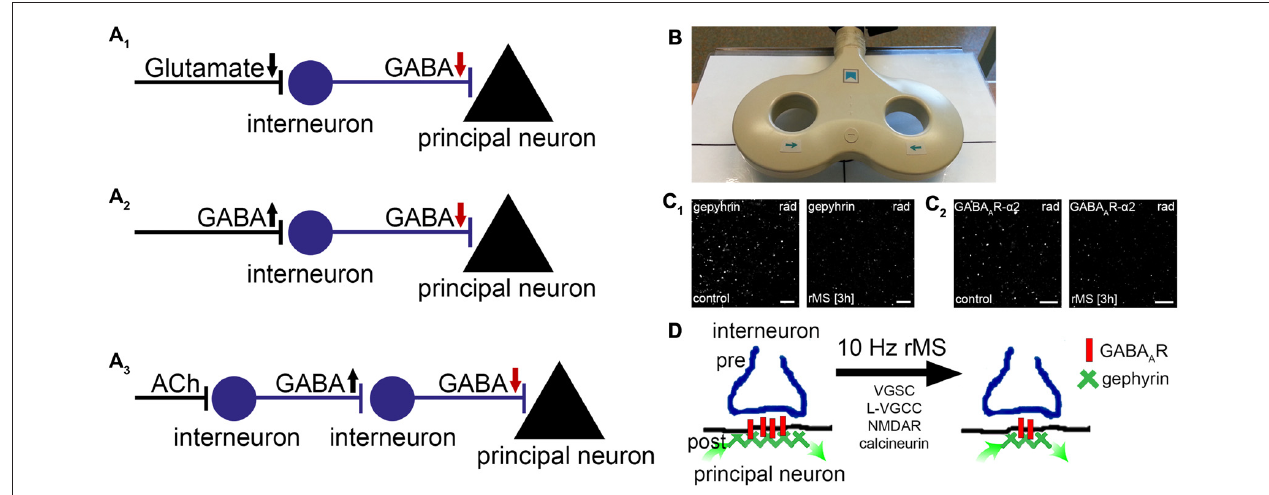
FIGURE 1 | Repetitive magnetic stimulation (rMS) induces long-term depression (LTD) of inhibitory postsynapses on principal neurons. (A 1 – 3 ) Local disinhibitory networks have been recently implicated in gating the ability of principal neurons to express associative excitatory synaptic plasticity. Schematic representation of mechanisms mediating disinhibition of principal neurons (gamma-aminobutyric acid, GABA; acetylcholine, ACh; arrows indicate direction of changes in neurotransmission). (B) Picture depicting a figure-of-eight magnetic stimulation coil (70 mm outer wing diameter). (C) Recent basic science work discloses that 10 Hz rMS induces Ca 2 + -dependent LTD of inhibitory postsynapses on principal neurons. These changes depend on the remodeling of gephyrin, the major postsynaptic scaffolding protein to which GABA A -receptors anchor. (C 1,2 ) show examples of original data illustrating changes in gephyrin and GABA A -receptor subunit α 2 clusters 3 h after 10 Hz rMS of organotypic slice cultures (CA1 stratum radiatum, rad; scale bars: 4 µ m; see, Lenz et al., 2016). (D) Activation of voltage-gated sodium channels (VGSC), L-type voltage-gated calcium channels (L-VGCC), N -methyl-D-aspartate receptors (NMDAR), and calcineurin protein phosphatase is required during stimulation for rMS-induced LTD of inhibition to occur. It is conceivable that rTMS-induced local disinhibition may facilitate the ability of stimulated neurons to express task-/input-specific associative excitatory synaptic